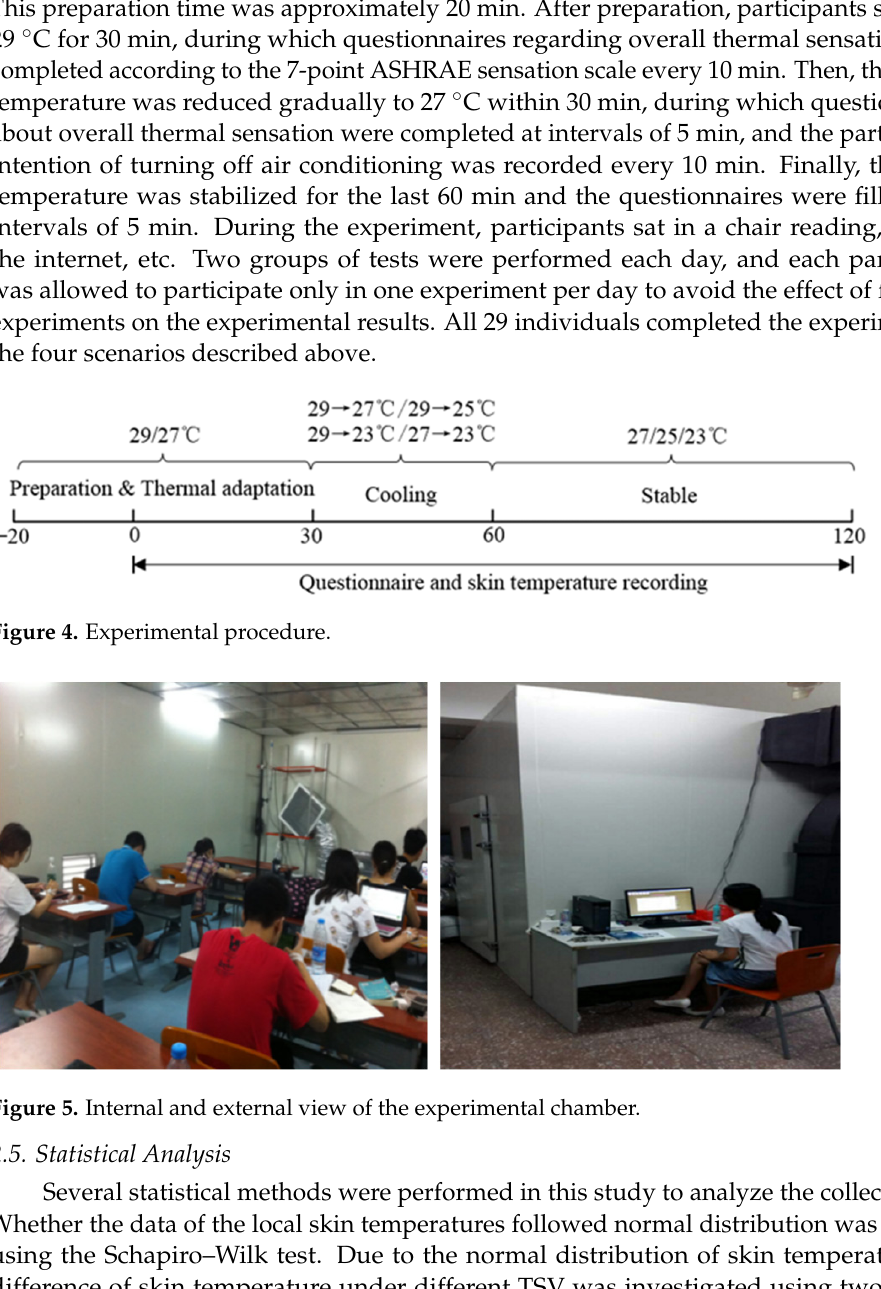
Figure 5. Internal and external view of the experimental chamber